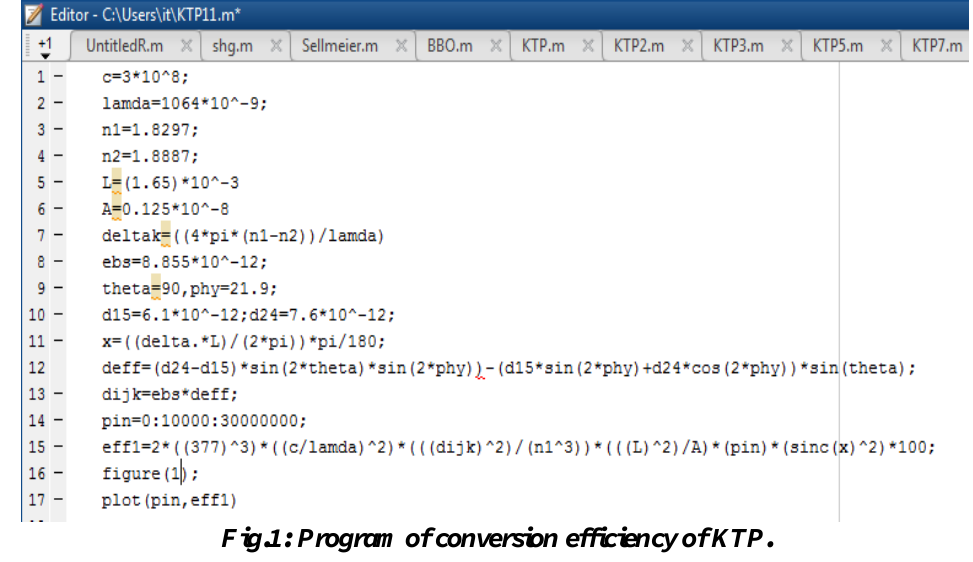
Fig.1: Program of conversion efficiency of